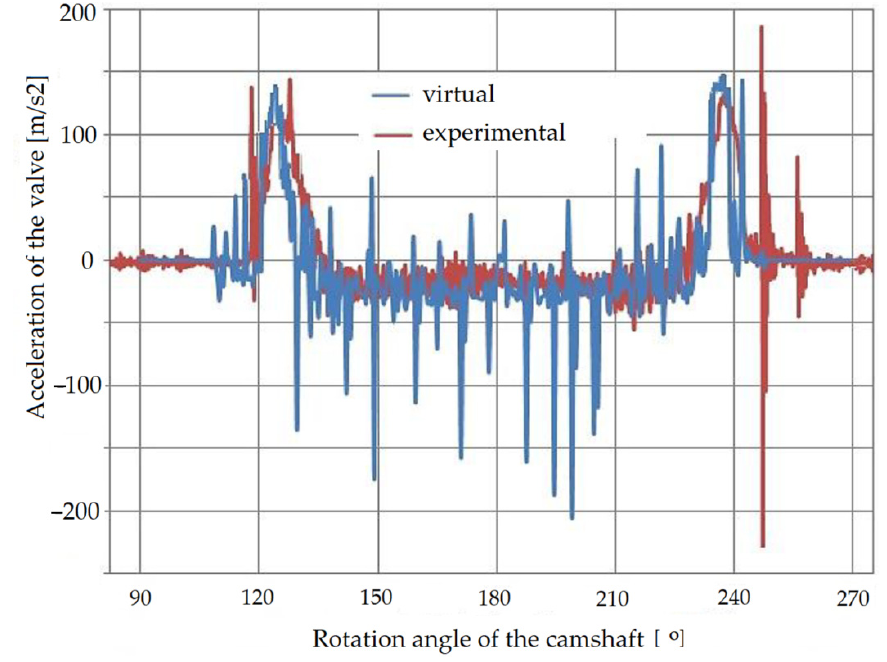
Figure 12. Valve acceleration for n AD = 350 rpm.